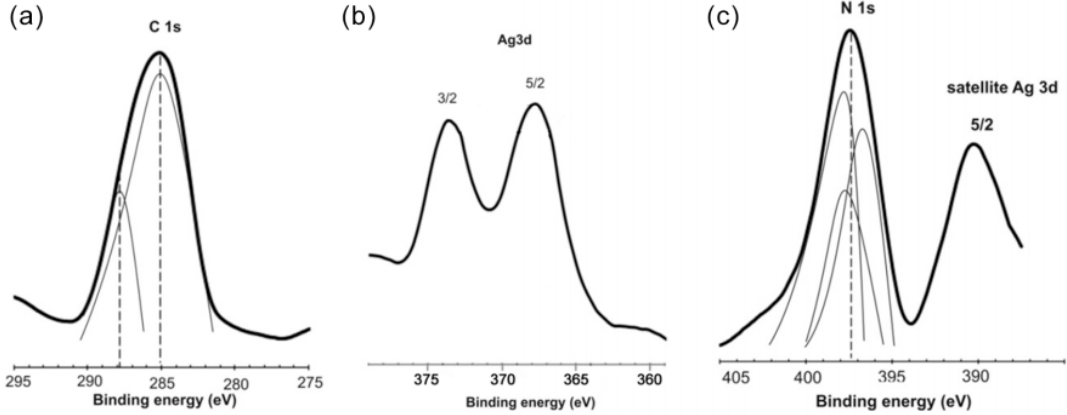
Figure 1. Typical XPS spectra for the Ag/PHMB sample ( a ) C 1s, ( b ) Ag 3d, and ( c ) N 1s photoelectron spectra (counts per second, cps vs. binding energy, B.E.).